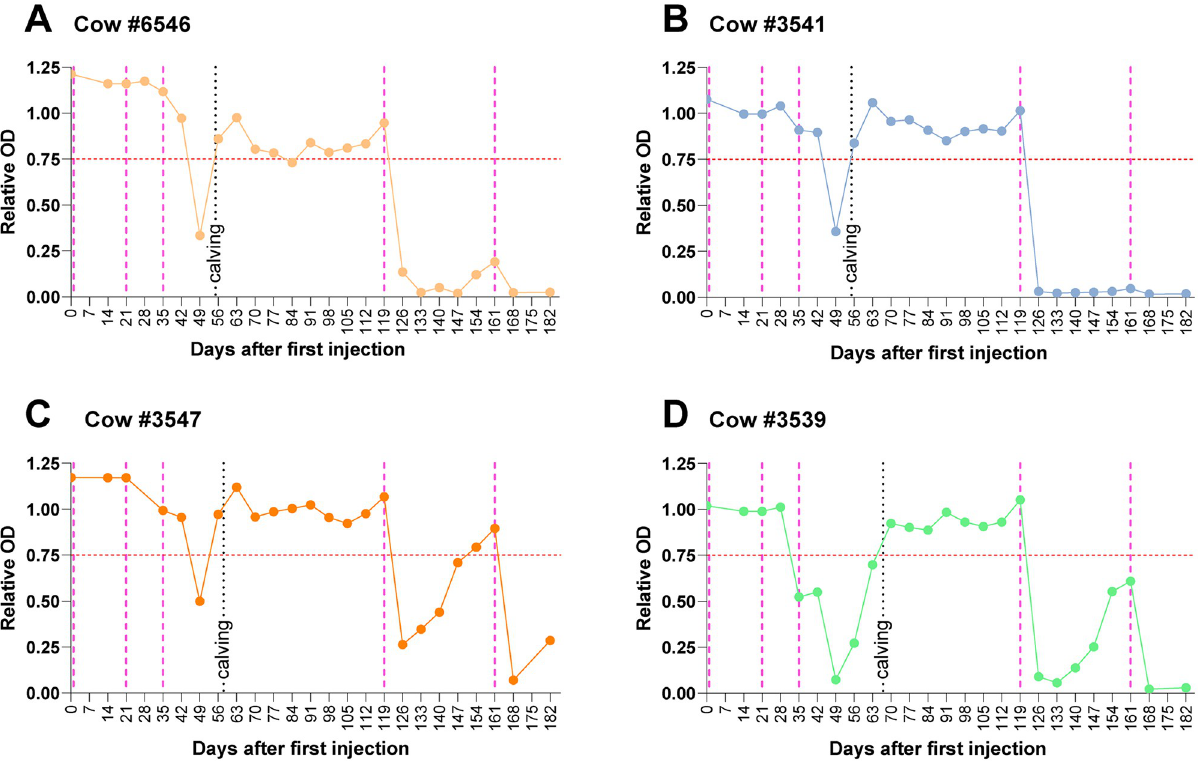
Fig 5. Blood serum neutralizing antibody titers over time after immunization and reimmunization of cows #6546, #3541, #3547 and #3539. The first three pink dotted lines indicate the days of initial immunizations before the first calving. The black dotted lines denote the days of calving, and the following two pink dotted lines indicate reimmunizations. The analyses were conducted using competitive ELISA (see the materials and methods section), and the red dotted line indicates the respective OD 450 of 0.75 (y-axis), above which neutralizing antibodies are not detectable and below which their presence is measurable. The x-axis shows the days after the initial injection for immunization. The connected line shows dots on each day that blood was drawn. This figure shows 4 examples of analyses that were indeed conducted for all cows included in the